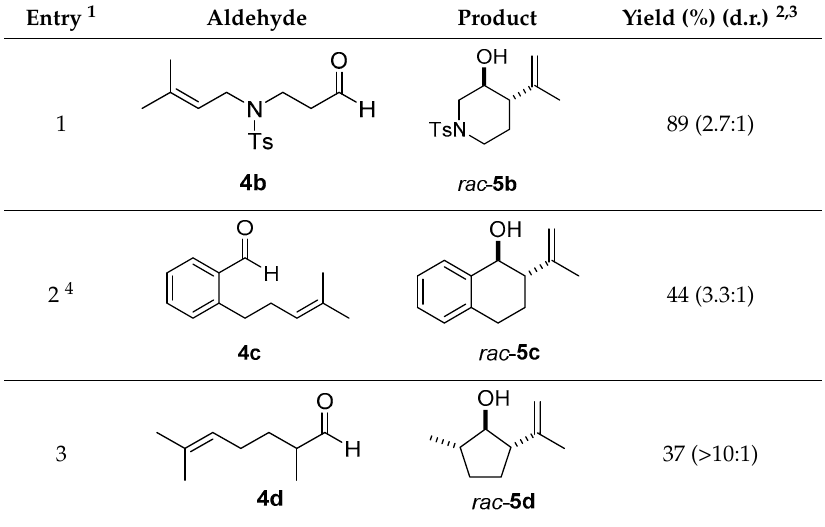
Table 3. Scope of the carbonyl-ene reaction of aldehydes.